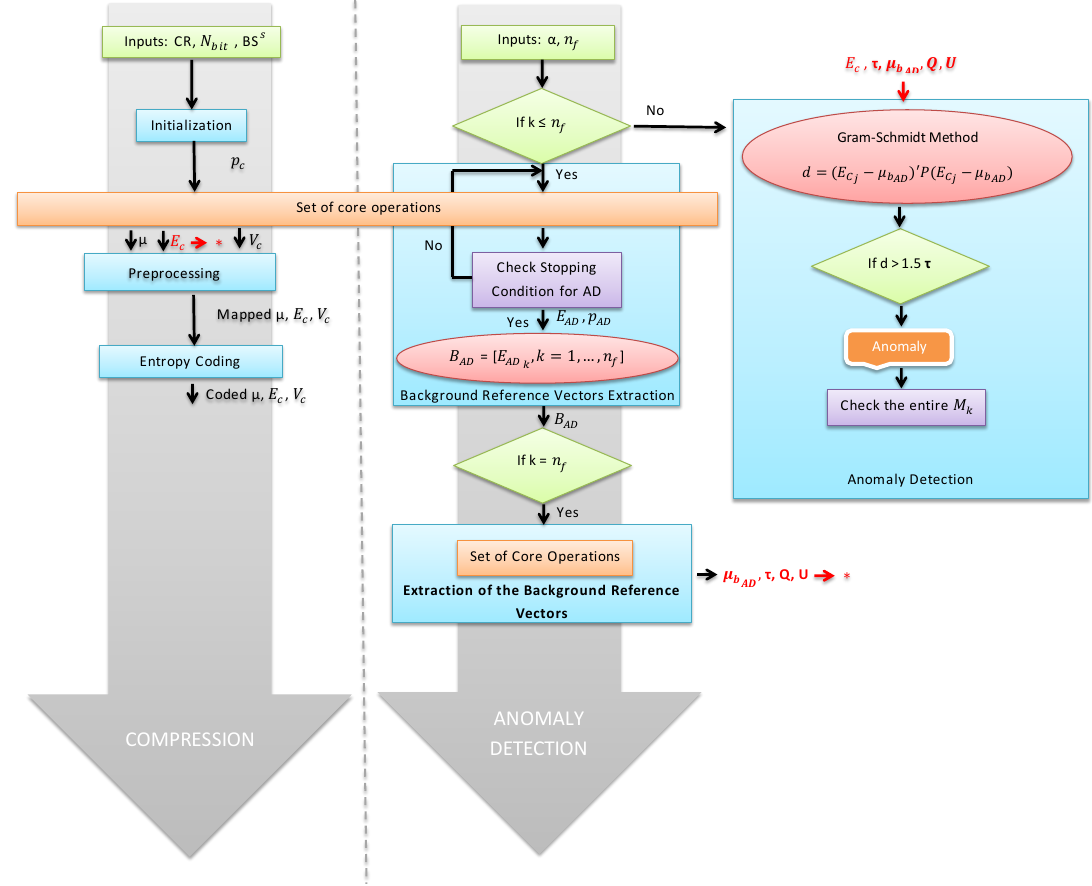
Figure 1. FLow-chart of the proposed algorithm stages for each image block M k . → * means that these variables are reused in other stages of the algorithm. If p c > p AD , then E AD is a subset of E c and